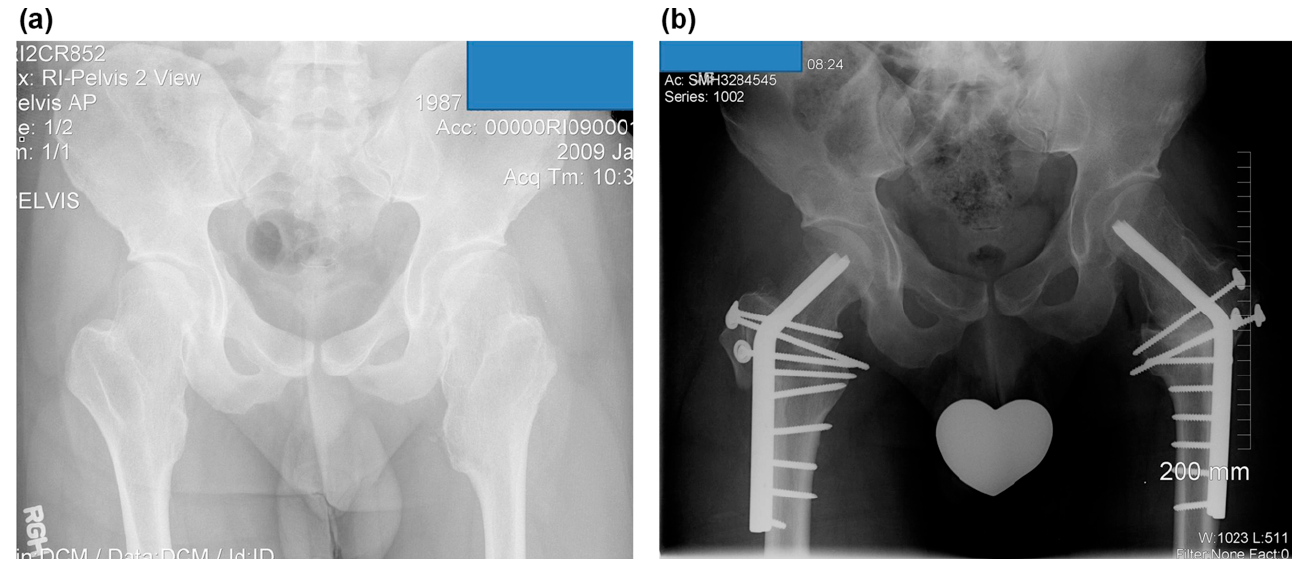
Figure 4. The case of a 22-year-old man with symptomatic bilateral femoroacetabular impingement in MHE (case no. 6). ( a ) A preoperative anteroposterior radiograph of the hip shows a large bump at the medial side of the femoral neck and severe coxa valga. ( b ) Postoperative anteroposterior radiograph of the hip. Valgus intertrochanteric osteotomies were performed on both hips using blade plates, and the trochanteric osteotomy sites were fixed with 3.5 mm cortical screws.